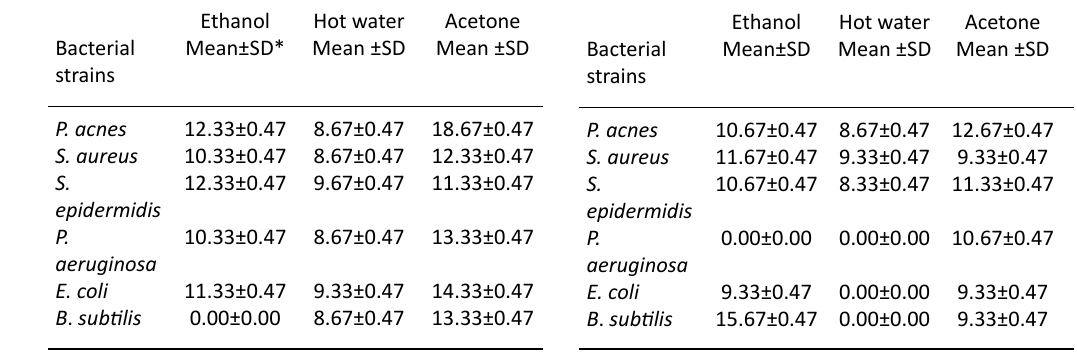
Table 3. Screening of antibacterial susceptibility of Cassia acutifolia extracts using three different solvents against bacterial isolates